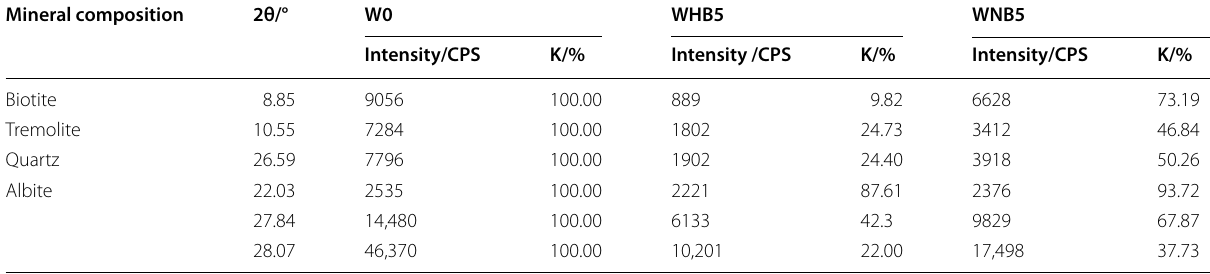
Table 4 Crystallinity of the main phase of tailings Mineral